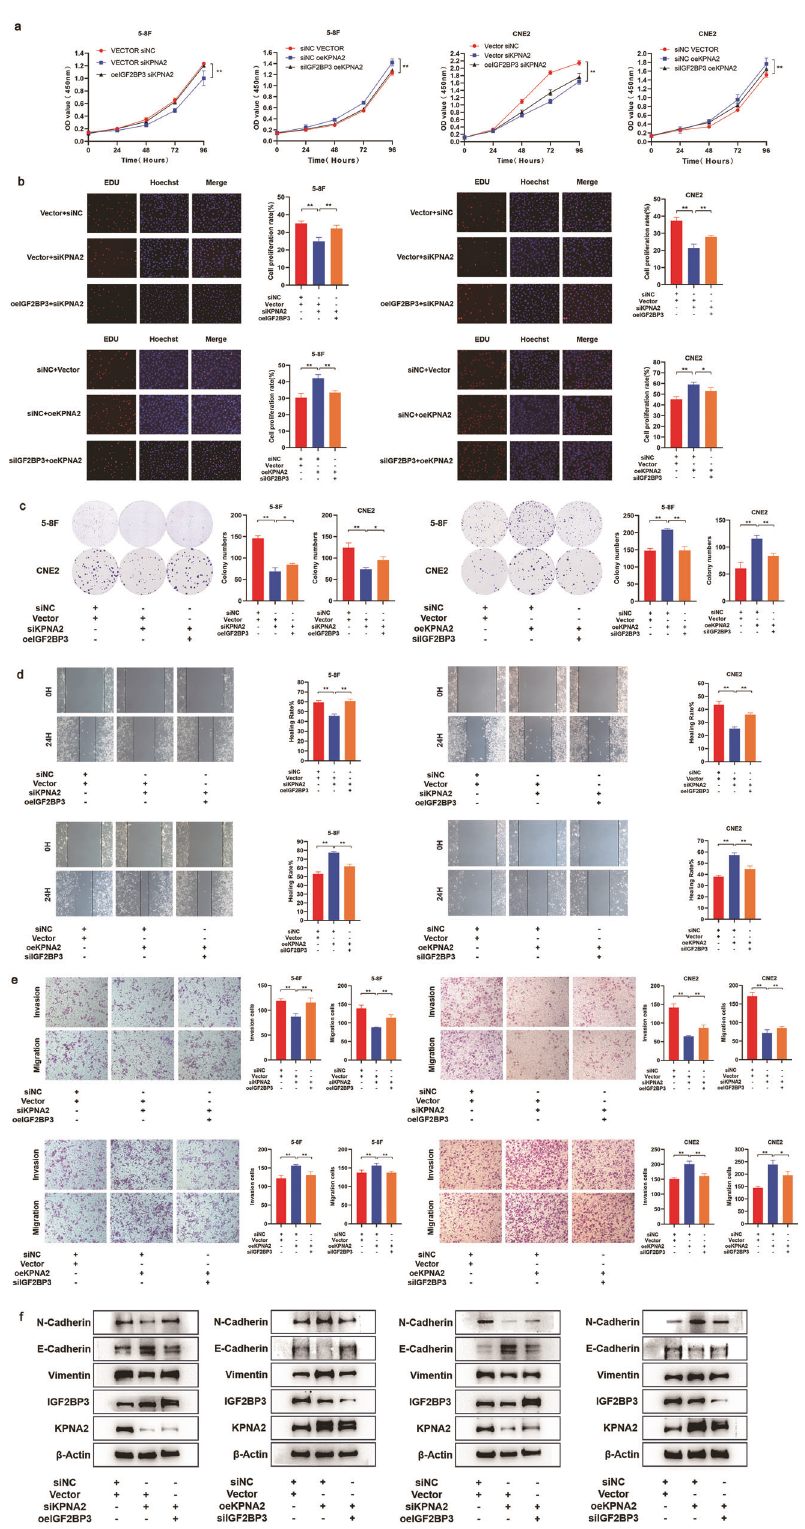
Fig. 5 IGF2BP3 regulates proliferation and metastasis of NPC cells through KPNA2 in vitro. a – g CCK8 ( a ), EDU assays ( b ), colony formation assays ( c ), wound healing assays ( d ), and transwell assays ( e ) of IGF2BP3 regulating KPNA2 on cell proliferation and metastasis. f Western blot results of the knockdown or overexpression of KPNA2 and IGF2BP3. Data was shown as the mean ± standard deviation of three independent experiments. * P < 0.05, ** P < 0.01.